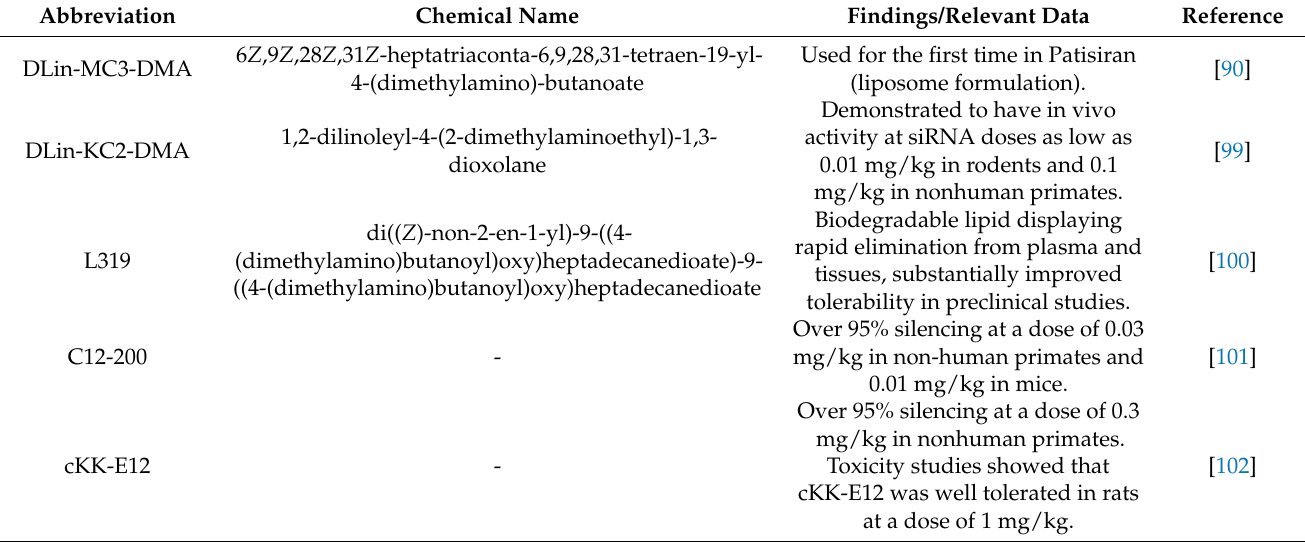
Table 1. Some ionizable lipids employed in the production of liposomes for gene